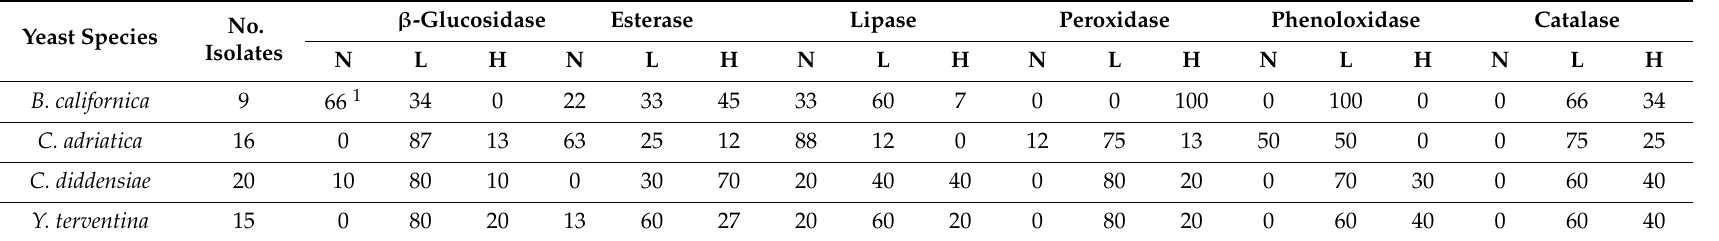
Table 5. Enzymatic activity in yeast species predominant in the extra virgin olive oils (EVOOs). β Yeast Species